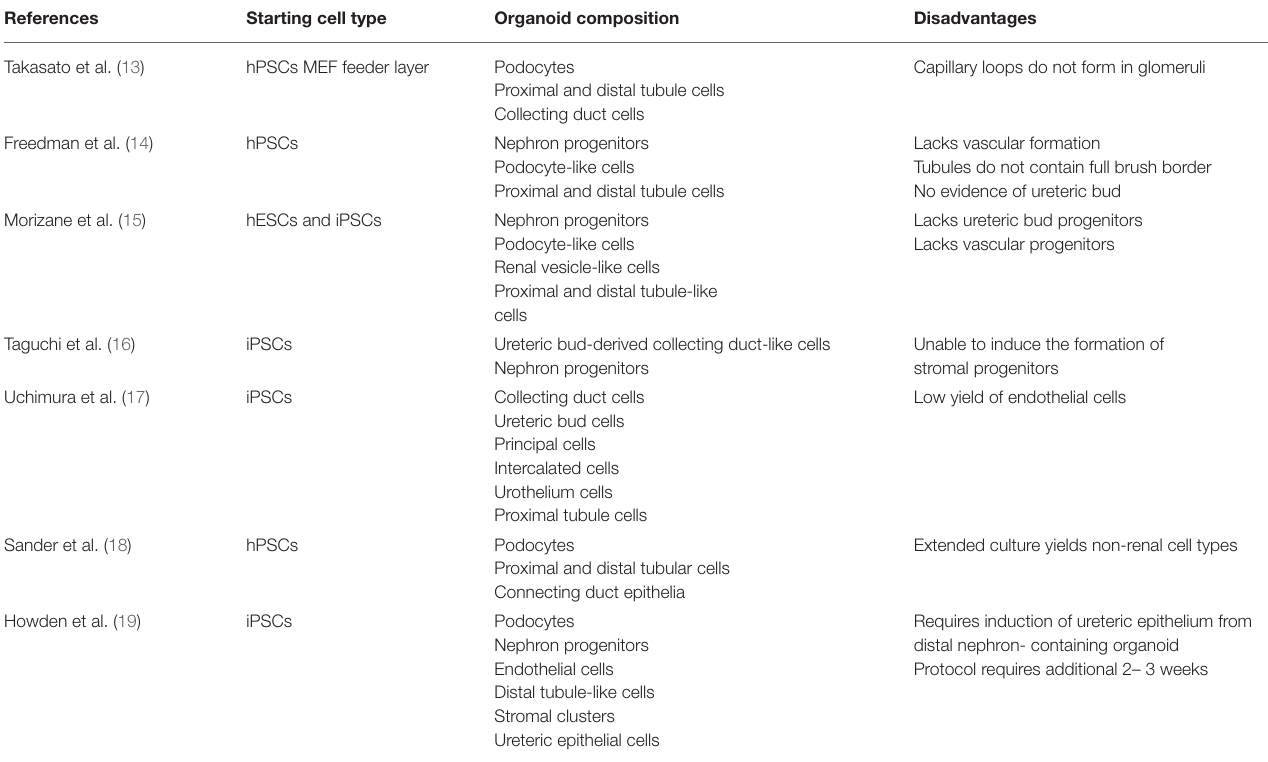
TABLE 1 | Advantages and disadvantages of kidney organoid differentiation